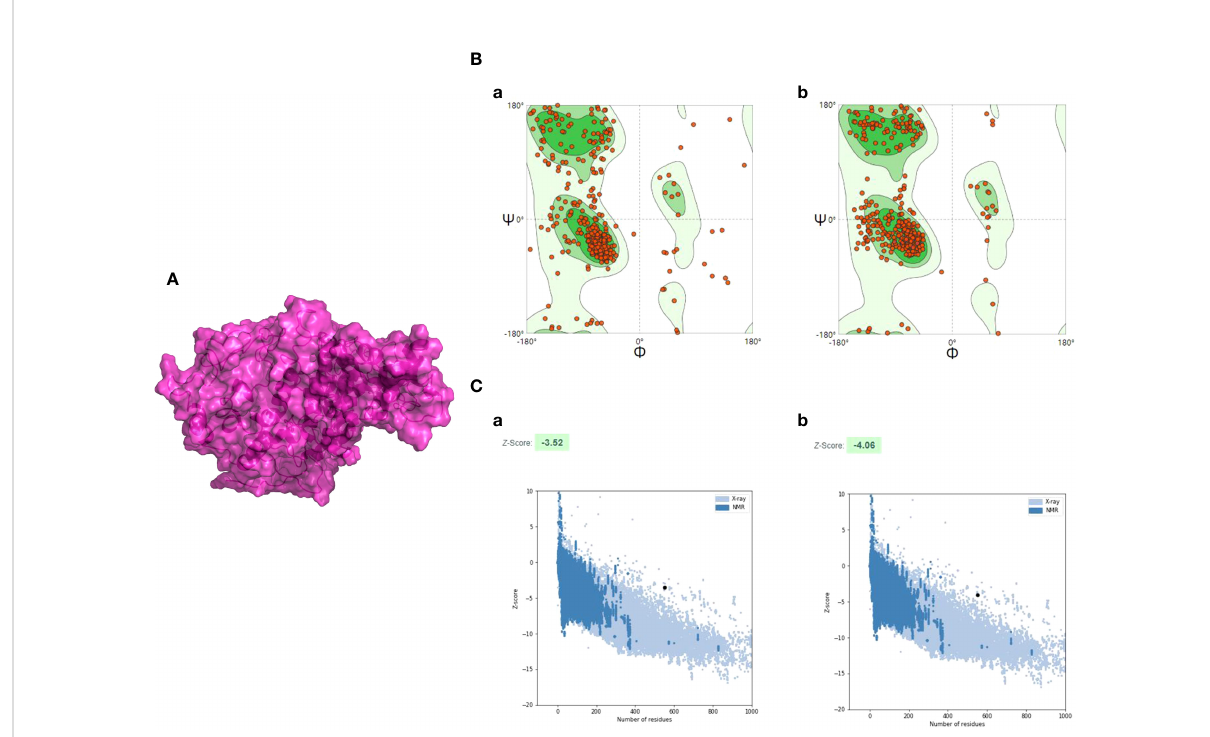
FIGURE 4 The re fi nement and quality assessment of the CVB vaccine construct. (A) The re fi nement model of the CVB vaccine construct. (B) (a) The Ramachandran plot of the primary model and (b) the Ramachandran plot of the re fi ned model. (C) (a) The Z -score of the initial model was − 3.52, and (b) the Z -score of the re fi ned model is − 4.06; both models were not in the range of native protein conformation. The Z -score plot contains Z -scores of all experimental protein chains in PDB determined by NMR spectroscopy (dark blue) and X-ray crystallography (light